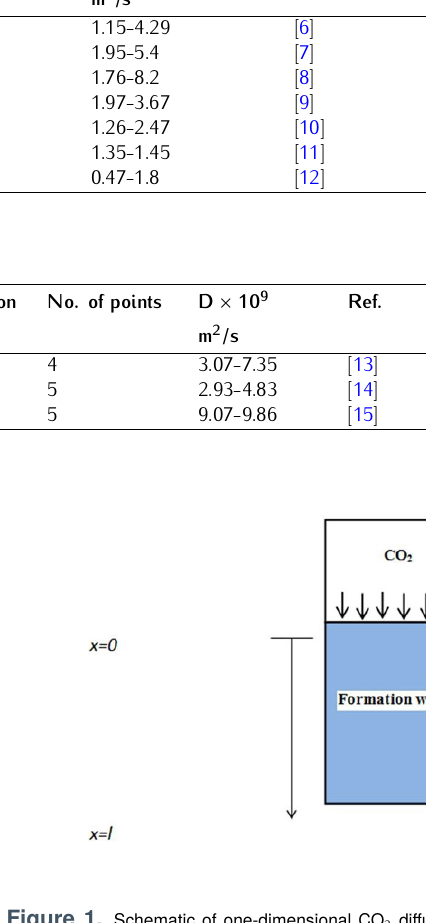
Figure 1. Schematic of one-dimensional CO